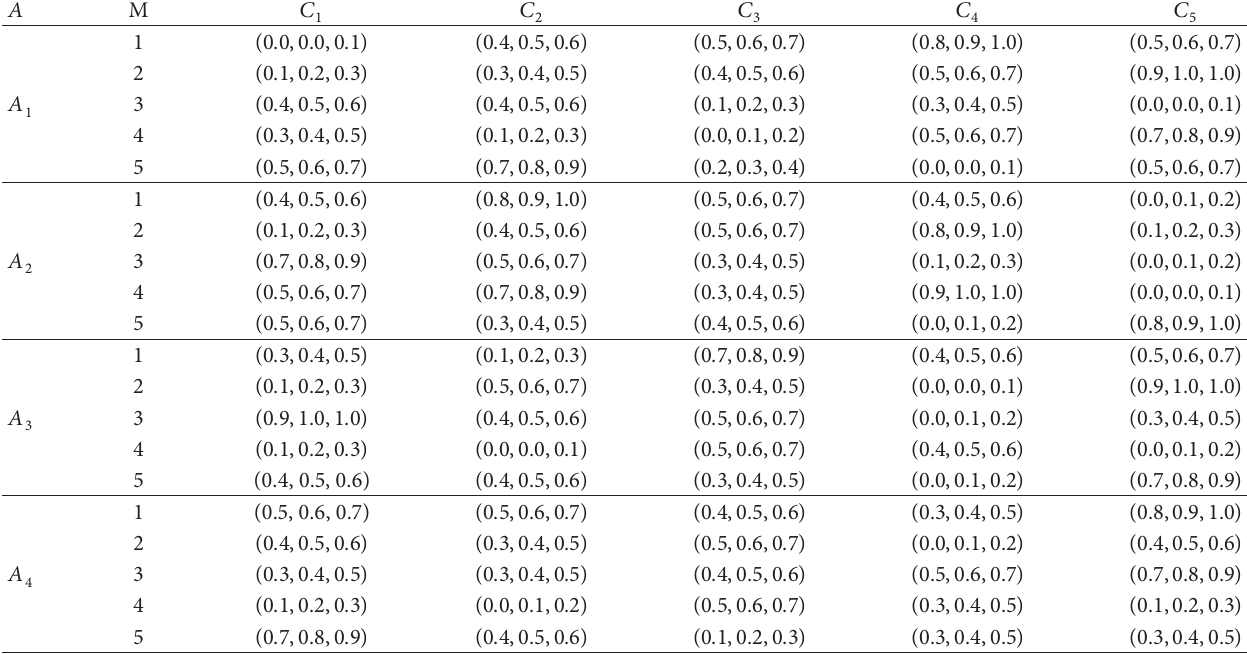
Table 2: Preference values of alternative given by 5 experts for TFNs.